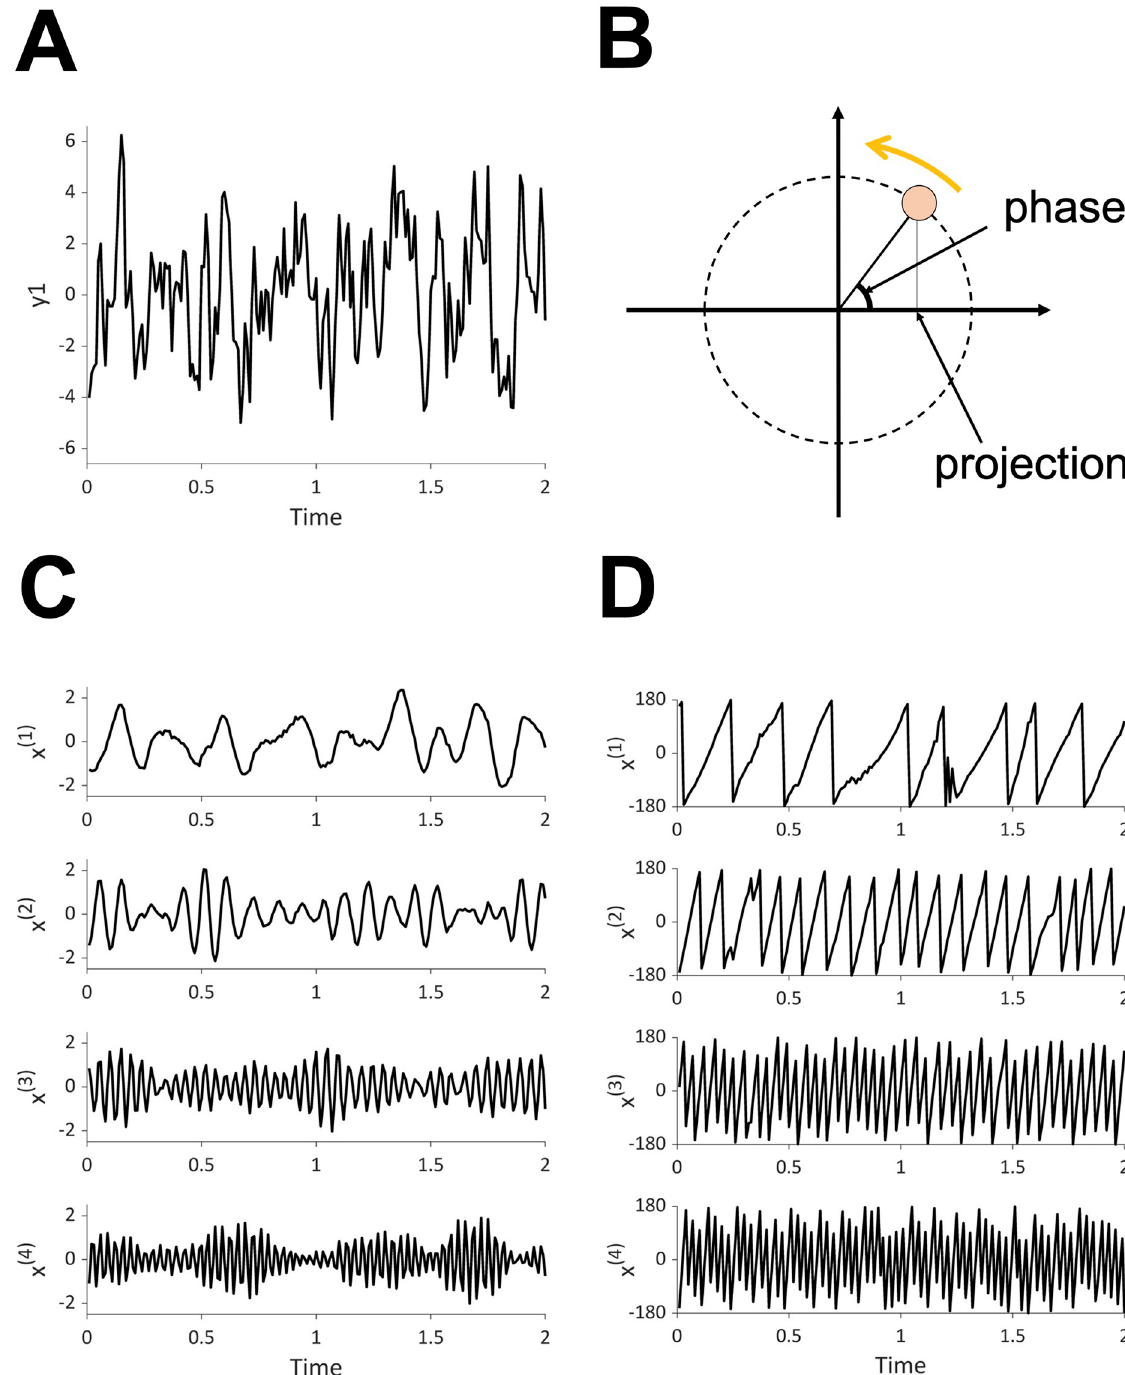
Fig 1. OSC-DECOMP for univariate time series data. (A) Input data. (B) Schematic of OSC-DECOMP. Each oscillation component is the projection onto the horizontal axis (first coordinate) of an oscillator that rotates on a plane with random fluctuation. (C) Decomposition into four oscillation components. (D) Phase of four oscillators (in